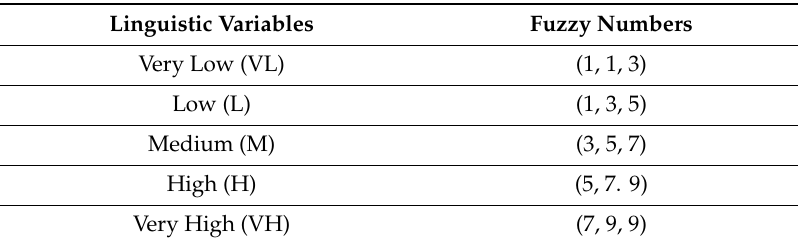
Table 1. Linguistic variables and their fuzzy number